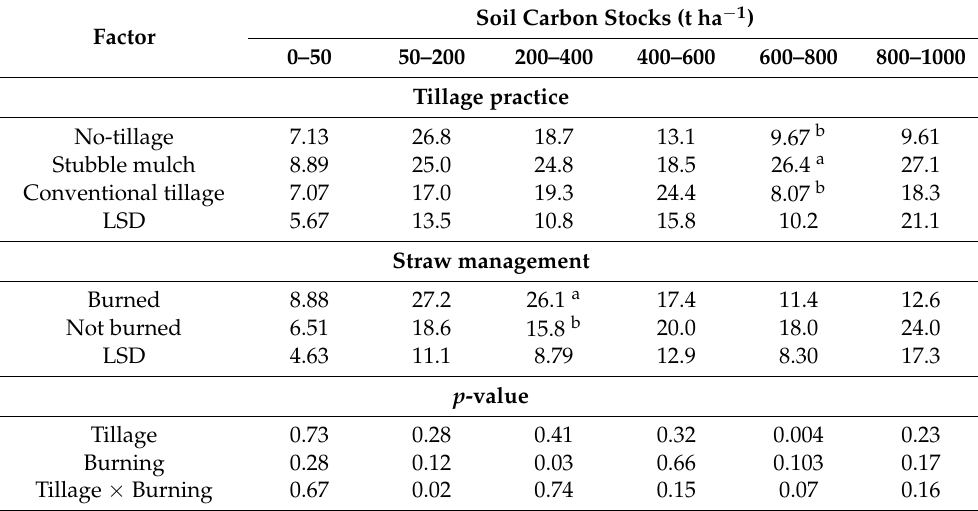
Table 3. Tillage and straw management effects on the soil carbon stocks (t ha − 1 ) at different soil layers